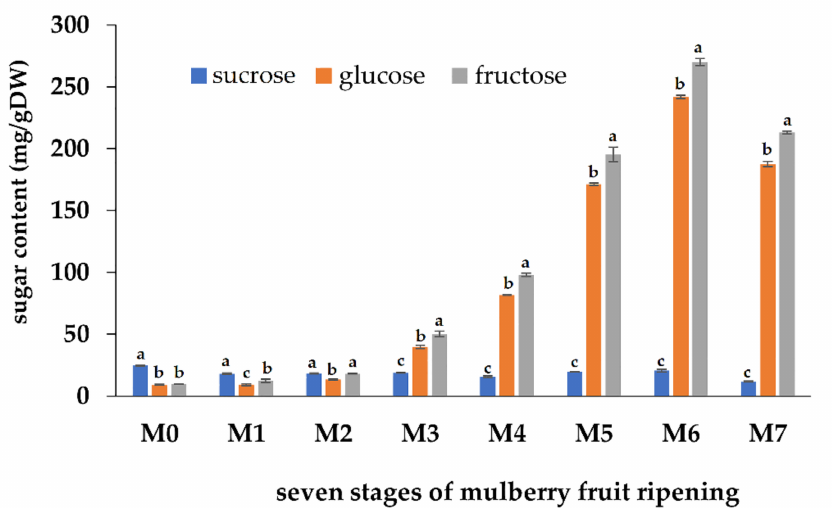
Figure 2. Sugar content in mulberry fruit during different ripening stages. Values are expressed as mean ± SD of triplicate measurements (n = 3). M0–M7 are mulberry fruits during ripening stages; means with different letters (a, b, c) are significantly different at p <